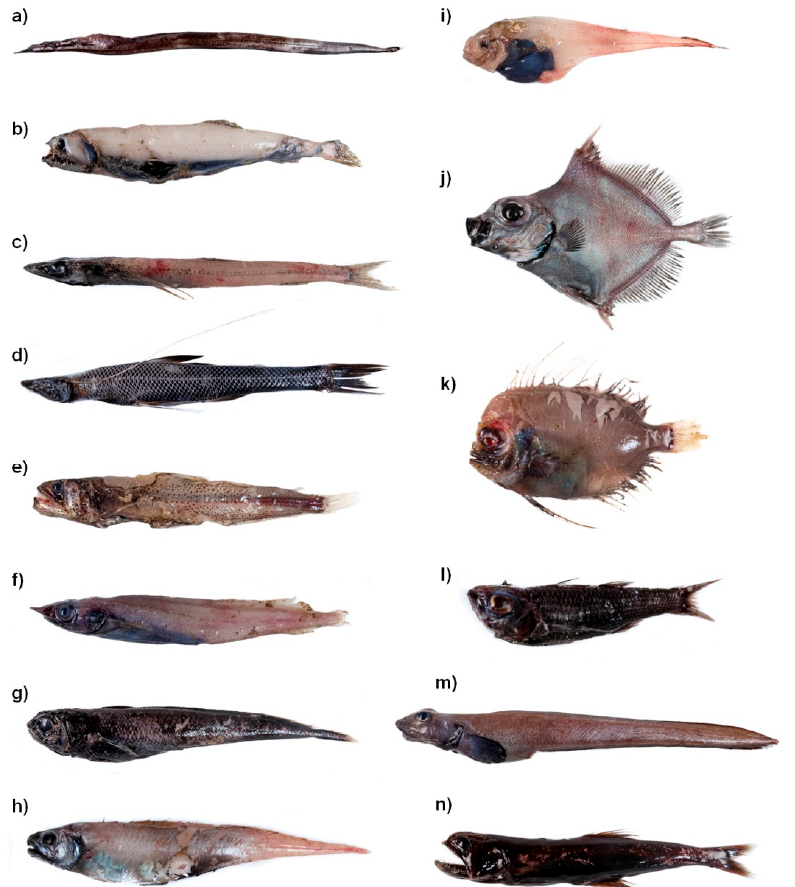
Figure 2. Deep-water fishes caught on the Porcupine Bank: ( a ) N. ingolfianus 462 mm TL; ( b ) B. antarcticus 266 mm TL; ( c ) S. lepidus 148 mm TL; ( d ) B. dubius 174 mm TL; ( e ) E. balbo 113 mm TL; ( f ) A. rostrata 107 mm TL; ( g ) M. zugmayeri 222 mm TL; ( h ) L. brachycolus 281 mm SL; ( i ) P. hystrix 106 mm TL; ( j ) N. helgae 142 mm TL; ( k ) P. opalescens 97 mm TL; ( l ) H. atlantica 100 mm TL; ( m ) L. terraenovae 365 mm TL; ( n ) P. altipinnis 136 mm TL (Photos: Francisco Baldó).